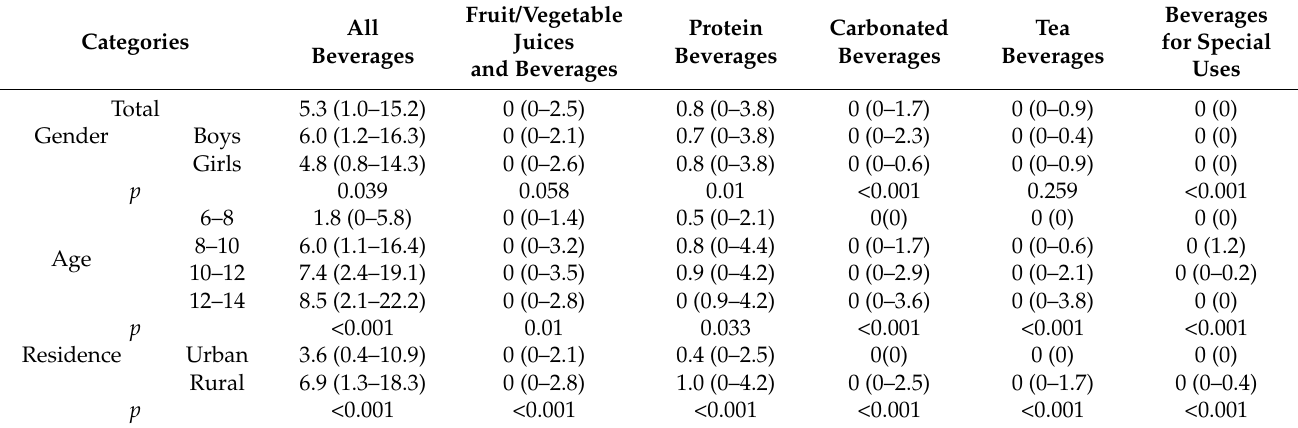
Table 4. Sugar intake from beverages in different groups of students (g/d, P50